Question: What direction does the quantity move in — increasing or decreasing?
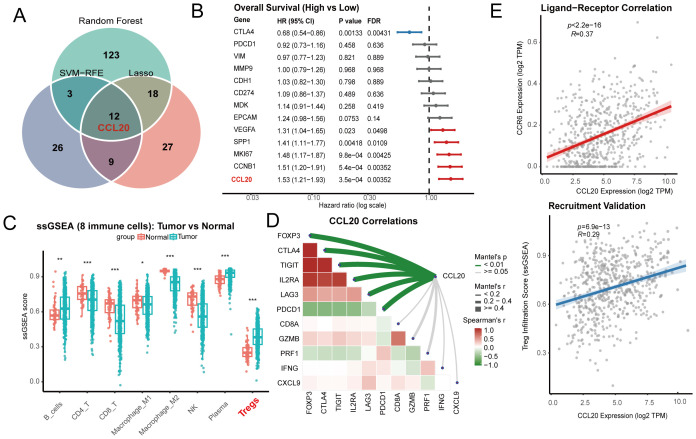
Answer: increasing